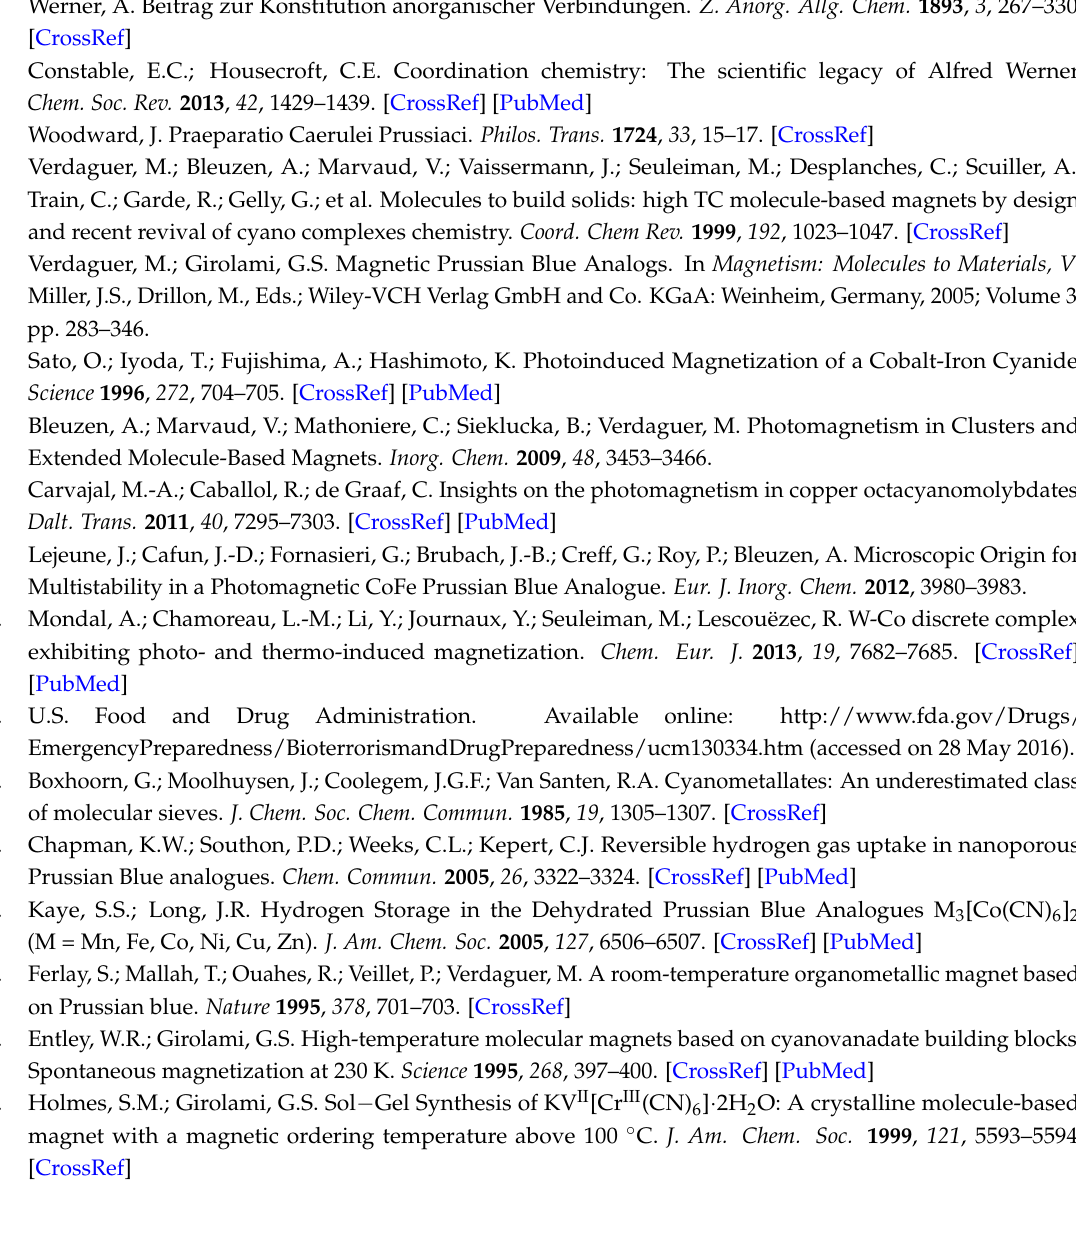
Figure S1: IR spectrum of ( n -Bu 4 N) 3 [Os(CN) 7 ] · 0.5H 2 O ( 1 ) (reflectance), Figure S2: CN – valance stretch region in the IR spectra of: ( n -Bu 4 N) 3 [Os(CN) 7 ](H 2 O) 0.5 (red) and ( n -Bu 4 N) 3 [Re(CN) 7 ] (black) (reflectance), Figure S3: MS-ESI spectrum of the reaction mixture of 1 : (a)-cationic part; (b) and (c)-anionic part, Figure S4: The